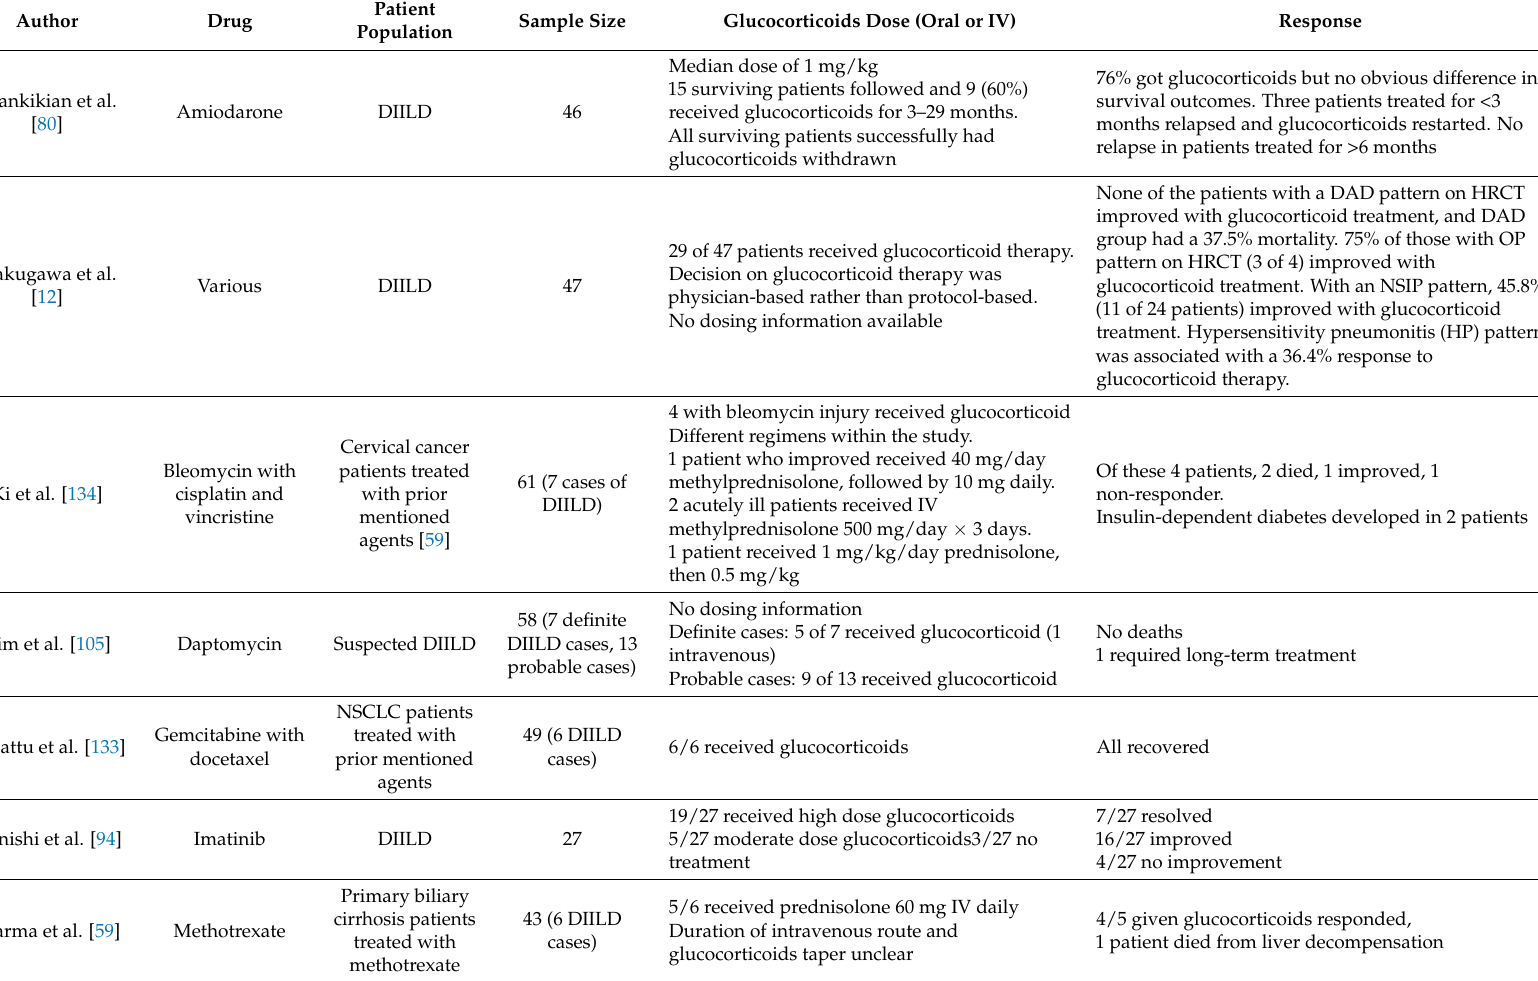
Table 3. Summary of studies which included information on use of